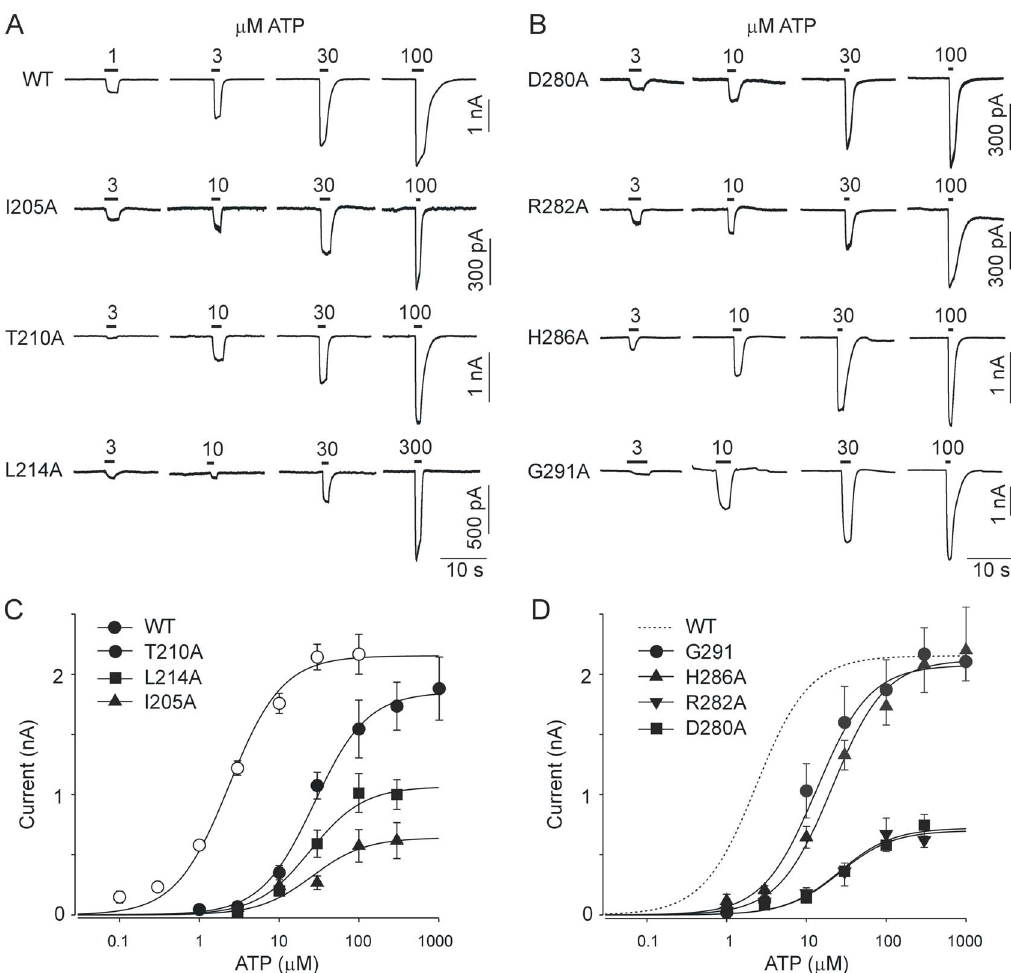
Figure 3. DF and LF mutants exhibit a rightward shift in EC 50 . (A, B) Example records of ATP-induced currents from cells expressing the WT receptor and I205A, T210A, and L214A DF mutants (A) and D280A, R282A, H286A, and G291A LF mutants (B). Currents were stimulated by a short (2– 5 s) application of different concentrations of ATP (1–1000 m M), indicated by horizontal bars above the traces. Experiments were performed on naı¨ve receptors, and traces from different cells are shown. (C, D) Concentration response curves for WT, I205A, T210A, and L214A DF mutants (C) and D280A, R282A, H286A, and G291A LF mutants (D). Data points are presented as the mean 6 SEM from 7–35 measurements per mutant, per concentration and 78 measurements for